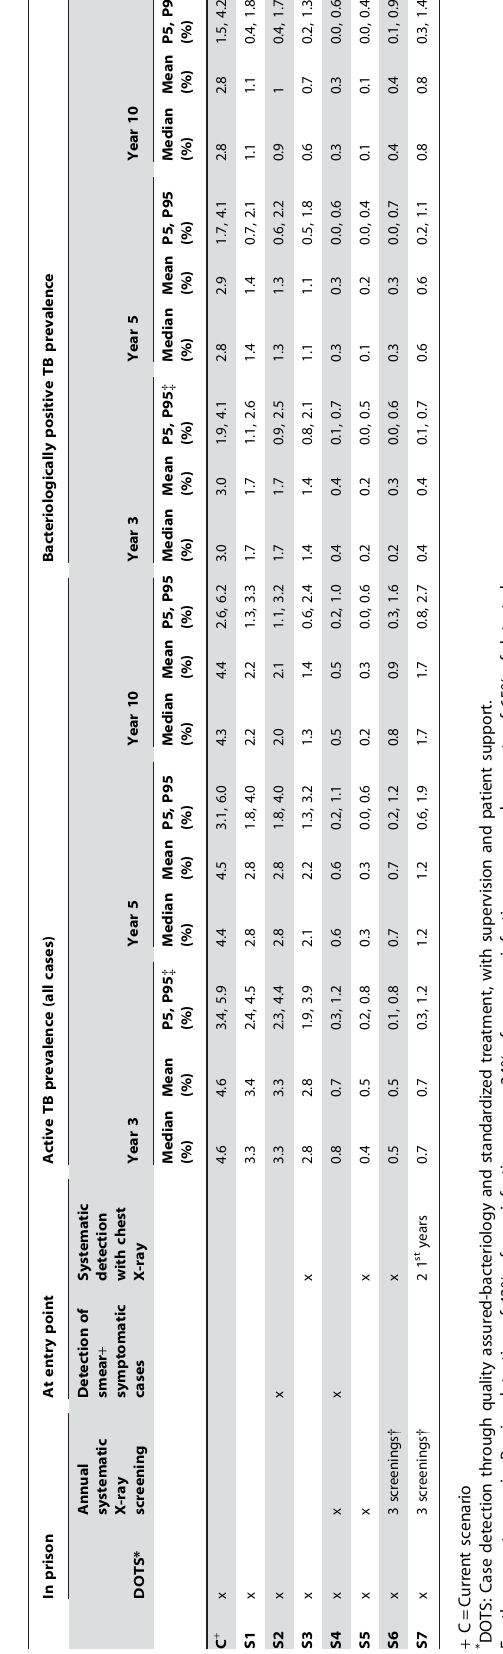
Table 2. Description of the transition rates in the model